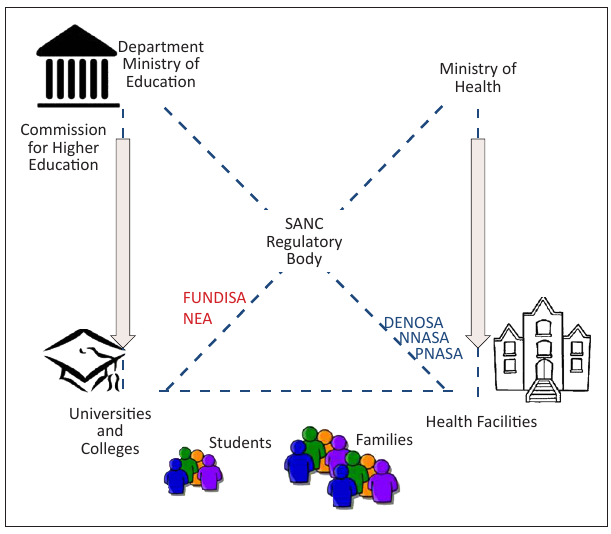
FIGURE 2: Stakeholder Grid: Plotting the landscape of Nurse Education and Training in South